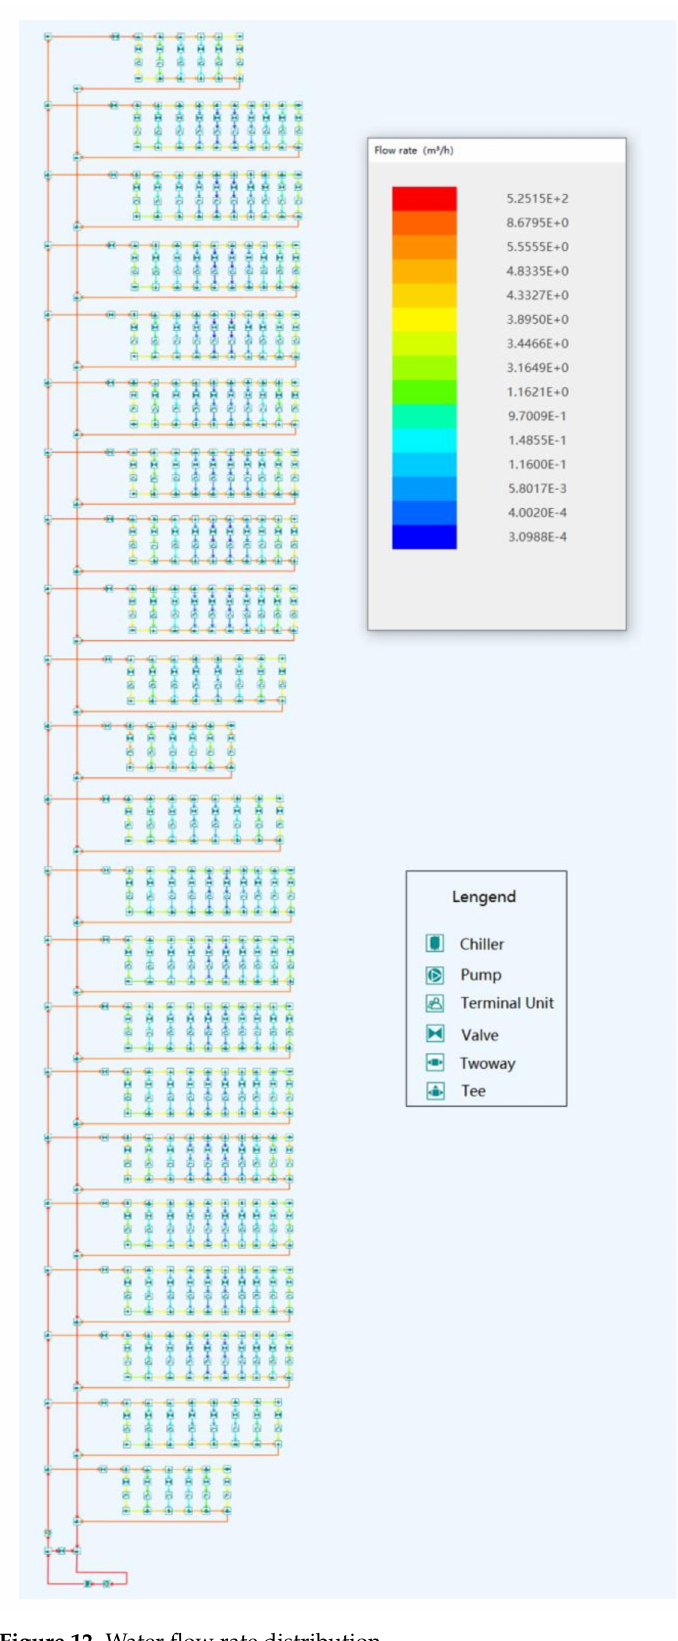
Figure 12. Water flow rate